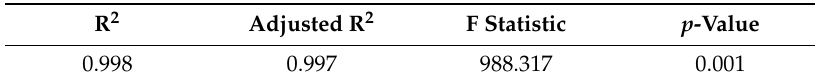
Table 3. OLS model summary.